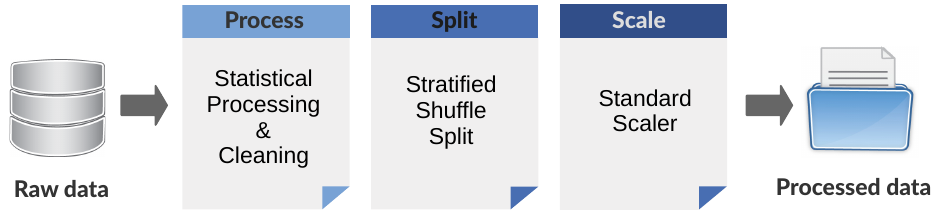
Figure 4. An overview of the data processing